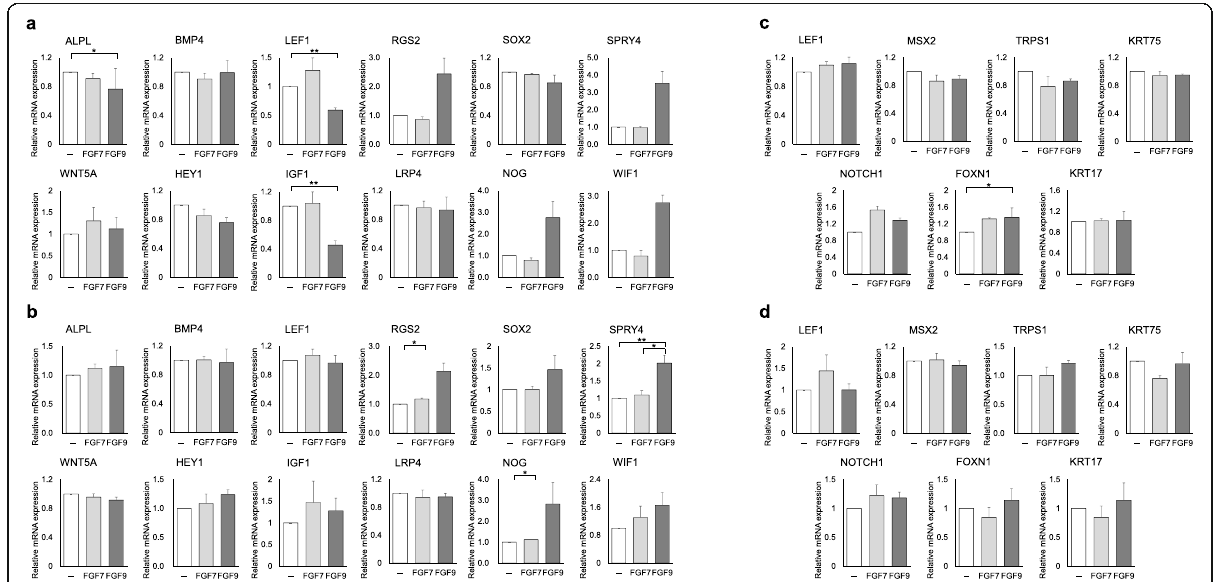
Fig. 3 Expression of biomarker genes in human dermal papilla cells and keratinocytes with or without FGF7 and FGF9. Expression of dermal papilla cell (DPC) biomarkers in DPCs in DPC single culture ( a ) and keratinocyte (KC) and DPC co-culture ( b ). Expression of hair follicle (HF) biomarkers in KCs in KC single culture ( c ) and KC-DPC co-culture ( d ). * p < 0.05. ** p < 0.01. The data were obtained from four experiments for a , b , and d and three experiments for